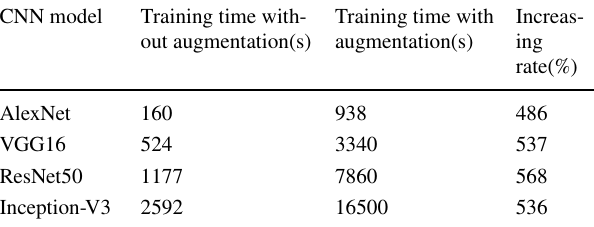
Table 4 Model training time before and after augmentation(%) CNN model